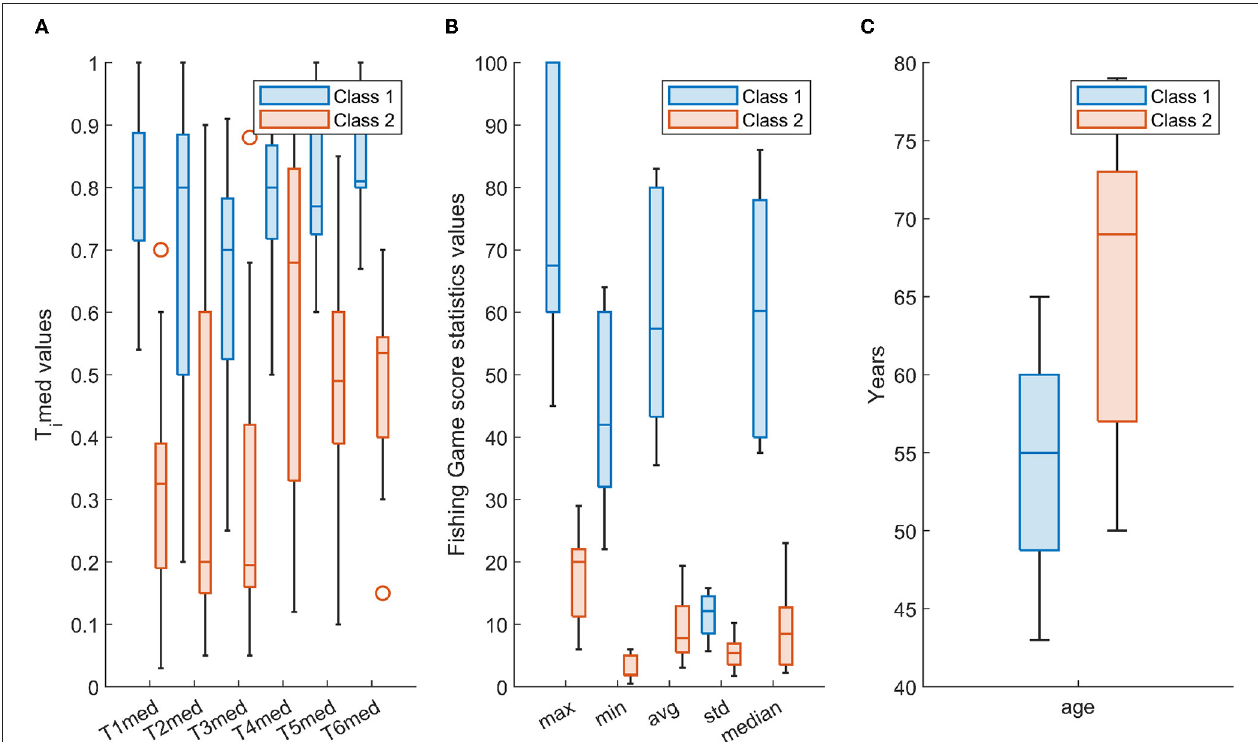
FIGURE 5 | The distribution per class (class 1-cyan; class 2-orange) of (A) Timed , i in the form of box-plotting. Each box ranges from the first quartile (Q1) to the third quartile (Q3) of the distribution and the range represents the interquartile range (IQR); the median is indicated by a line across the box and the “whiskers” on box plots extend from Q1 and Q3 to the most extreme data points; outliers are indicated with circles.